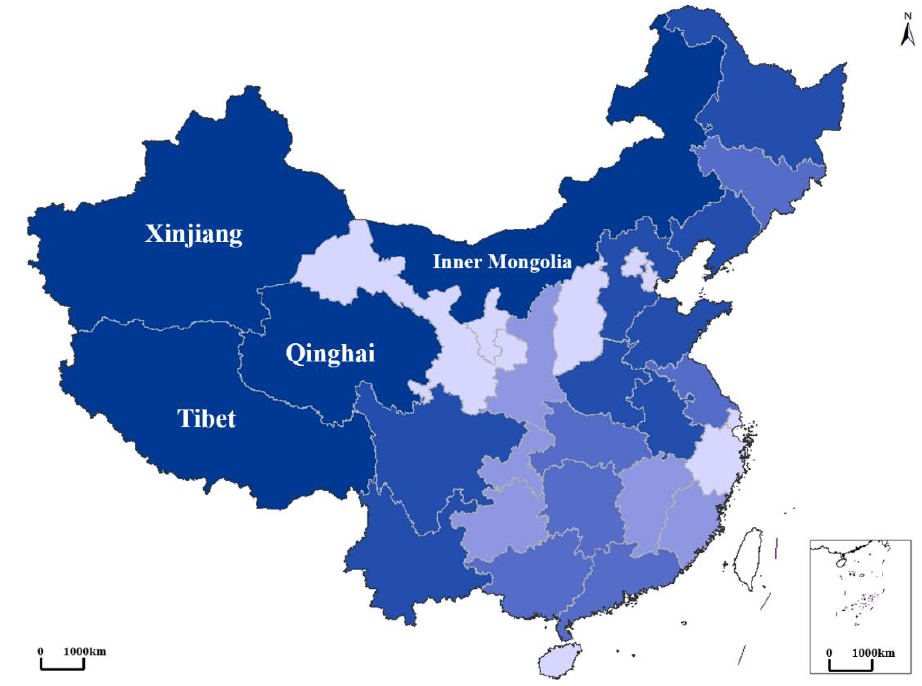
Figure 4. Major pastoral areas in China (based on grassland area, livestock volume, and beef and sheep output).